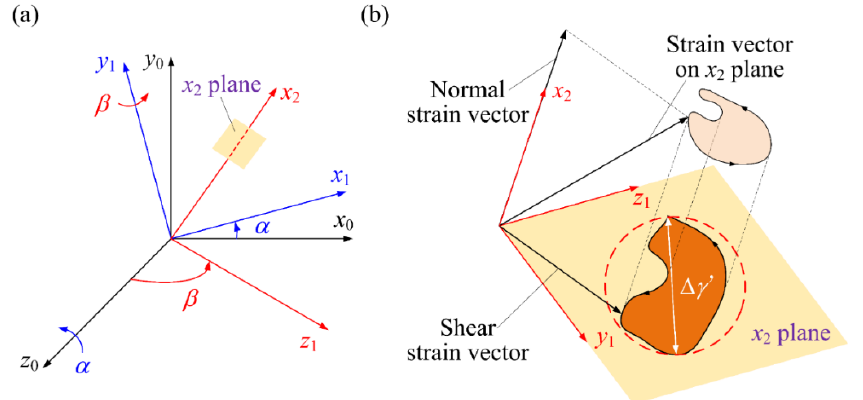
Figure 4. ( a ) Geometrical definition of Euler angles and ( b ) the Minimum-Circumscribed Circle proposal [28,29]. proposal